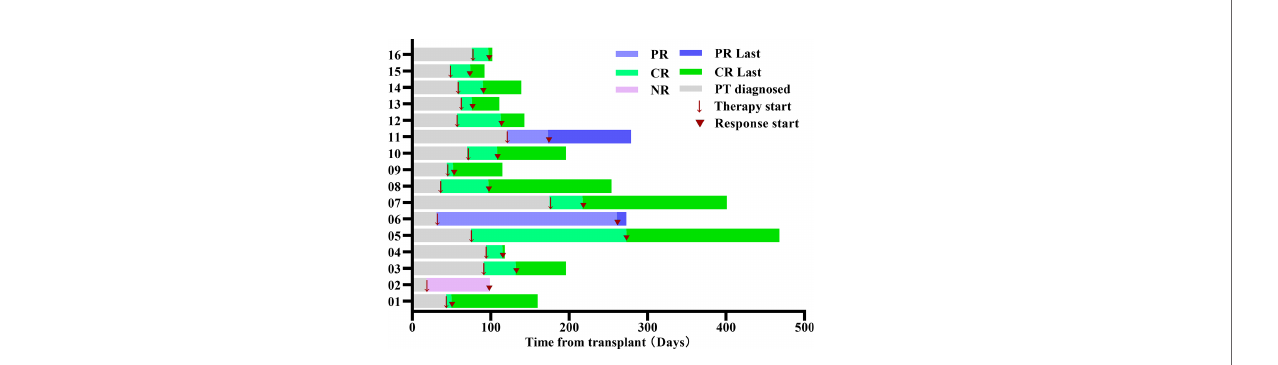
FIGURE 1 | Swimmer plot for the response evaluable patients. Each bar represents an individual patient as designated. Arrow indicates the time of treatment. Triangle indicates the start time of clinical response. PR, partial response; CR, Complete response; NR,